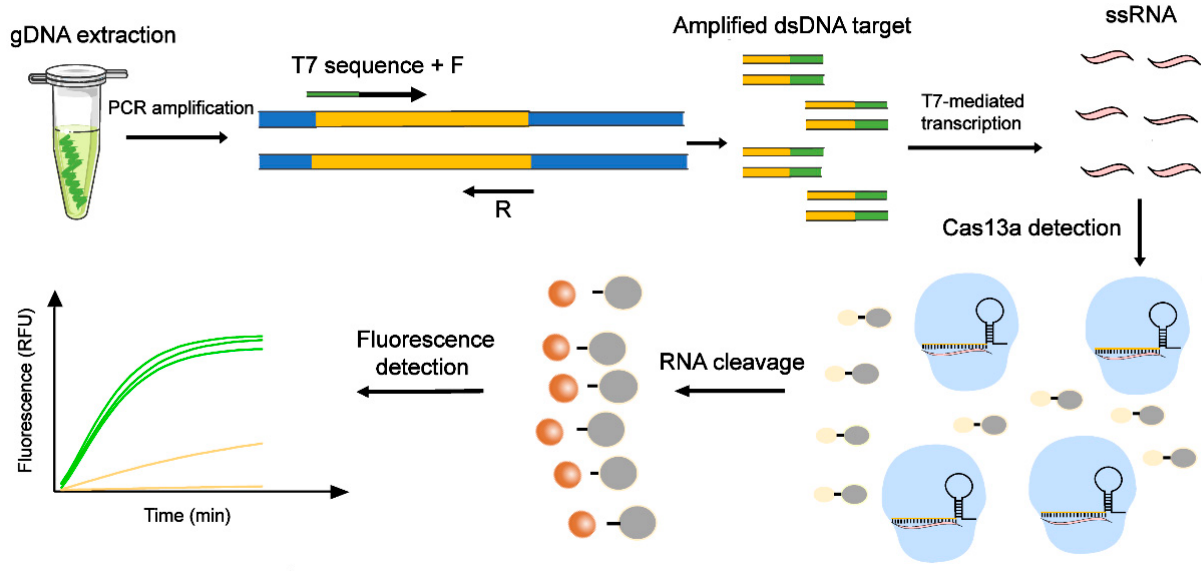
Figure 2. Schematic diagram of the workflow of the PCR-Cas13a system. The extracted genomic DNA was added into the PCR reaction for amplification. The binding of the Cas13a/crRNA complex to the ssRNA transcribed by amplified H. pylori DNA targets triggered the collateral activity of Cas13a, which cleaved RNA reporters. The cleaved RNA reporters were detected by fluorescence signals.